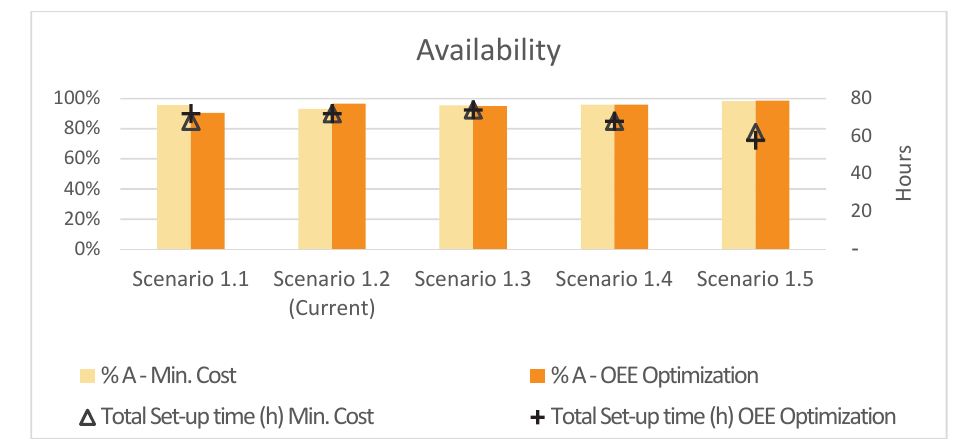
Fig. 5. Performance rate comparison per scenario